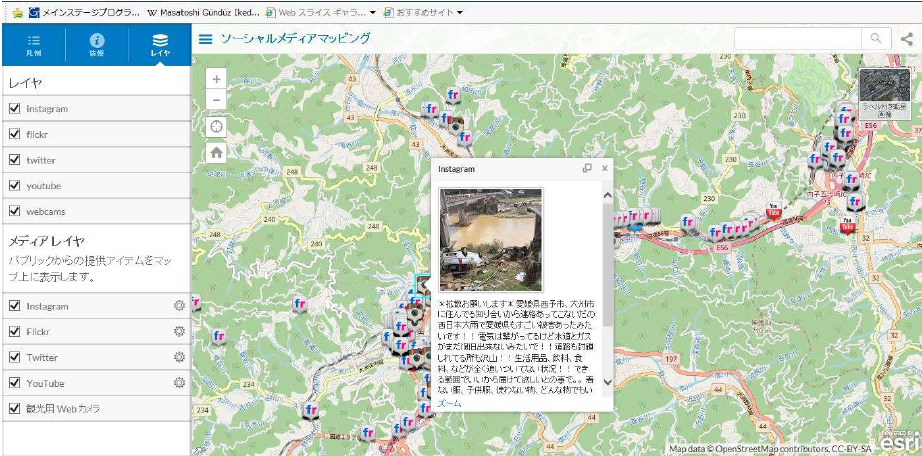
Fig. 6. Information related to the seriously damaged area in the central part of Ohzu City, Ehime Prefecture using